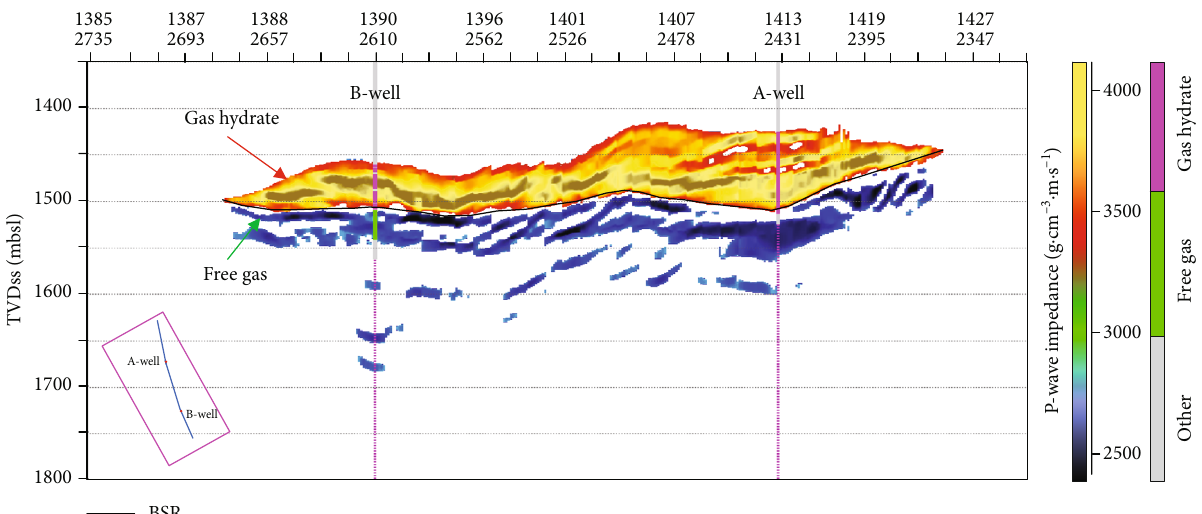
Figure 10: Well-tie P -wave impedance cross section of the A-well and